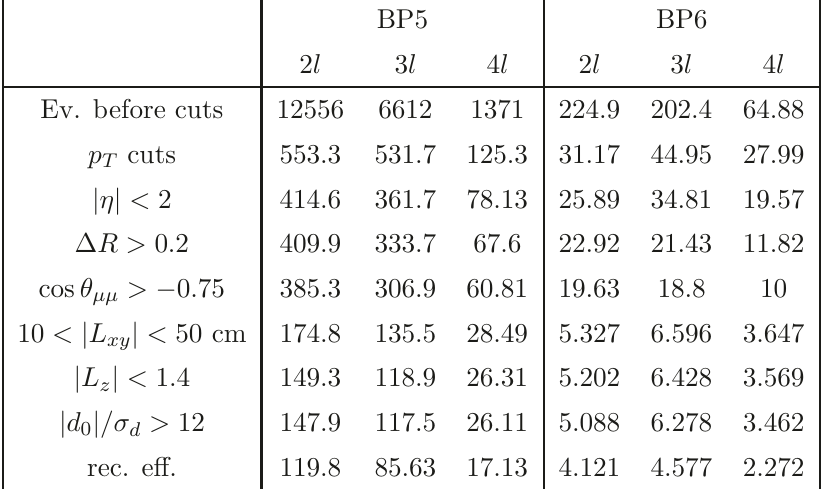
Table 11. Displaced leptons originated from heavy neutrinos produced by the heavy Higgs. For each BP the initial number of events generated is the cross section σ ( pp by a luminosity of 100 fb − 1 . The p T cuts are applied in the following way: p T > 26 GeV for the two most energetic muons and p T > 5 GeV for all the others. The reconstruction efficiency of the leptons is taken into